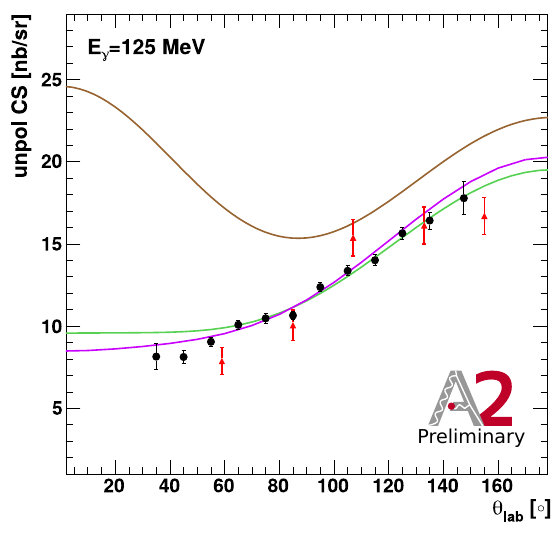
Figure 3. Preliminary unpolarized cross section (black cir- cles) [18], compared to the previous results from Ref. [12] (red triangles). The curves correspond to the Born contribution (brown), Dispersion Relation calculation (magenta) [20, 21], and heavy baryon ChPT calculation (green) [22]. The Dispersion Re- lation and heavy baryon ChPT calculations were performed for